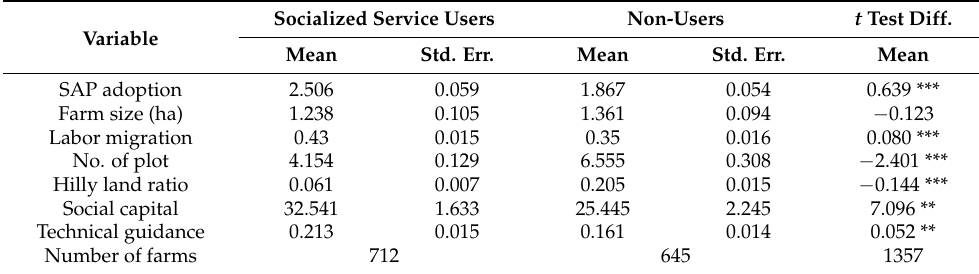
Table 3. Mean differences of variables between socialized service users and non-users.